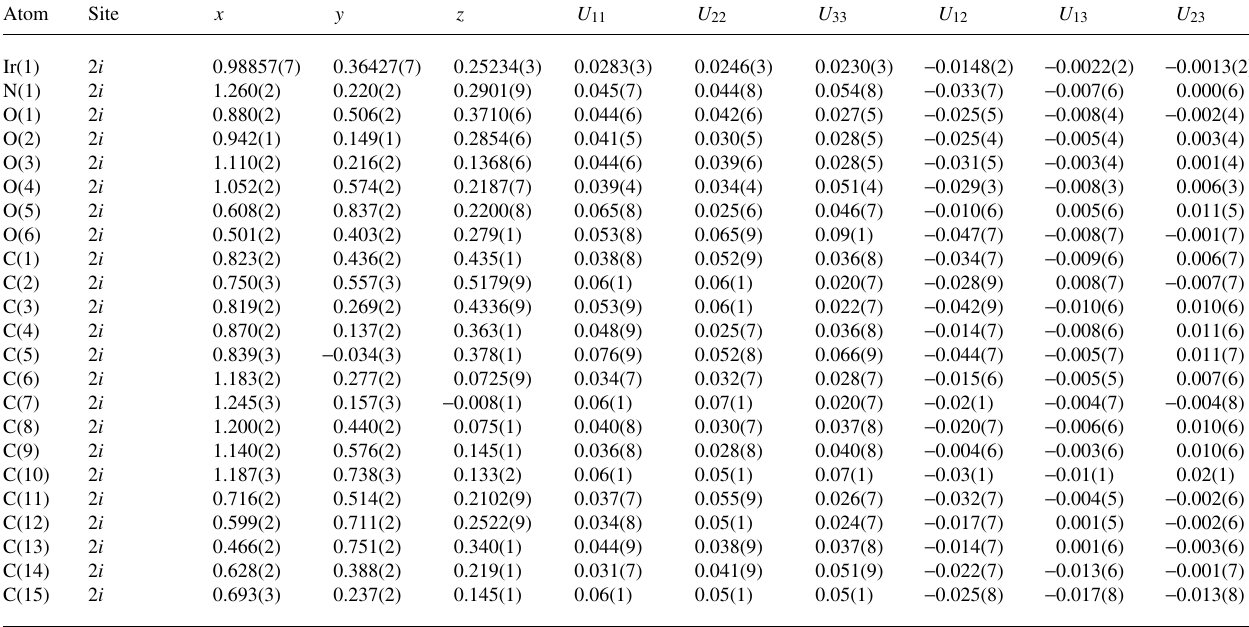
Table 3. Atomic coordinates and displacement parameters (in Å 2 )